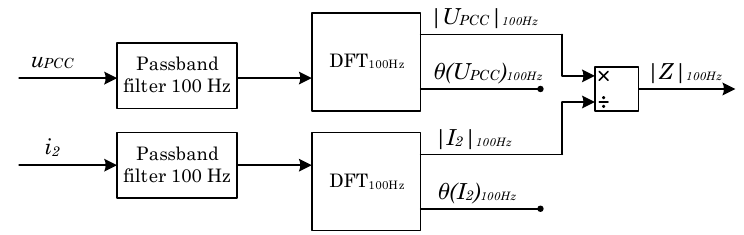
Figure 14. Impedance measurement diagram.